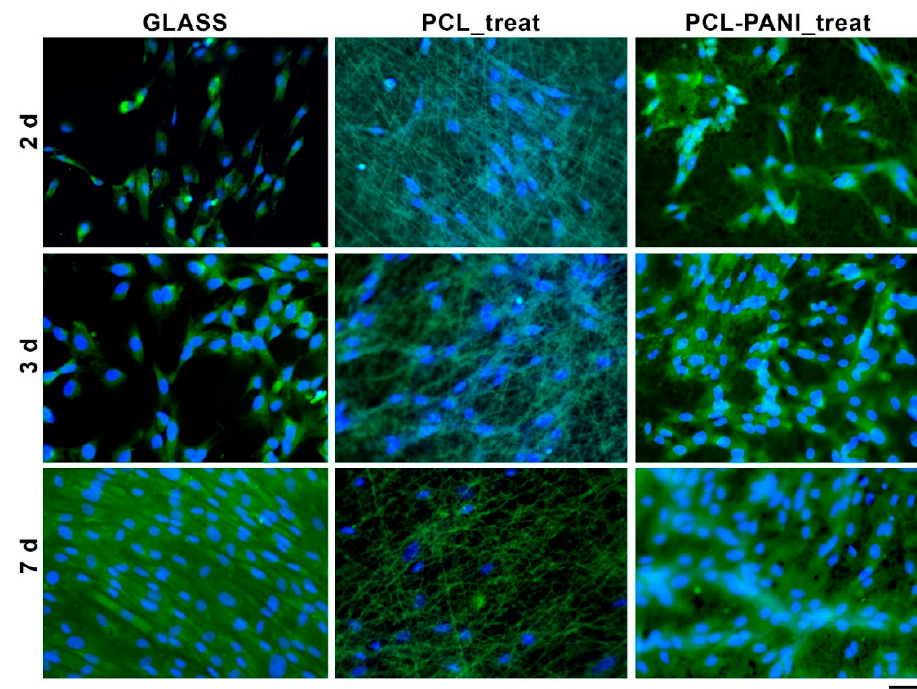
Figure 9. Fluorescent microscopy images of HFF-1 stained with FITC phalloidin (actin filaments) and DAPI (nuclei) after 2, 3 and 7 days of culture (scale bar = 50 µm, magnification = 20×). According to the results obtained from the resazurin assay, the number of cells on the PCL-PANI_treat mats was higher than that on the PCL_treat and GLASS samples at days 2 and 3. Therefore, after 7 days, the cells were uniformly distributed along the direction of the electrospun fibers. The attachment of HFF-1 cells on the electrospun mats was also investigated through FESEM microscopy (Figure 10). The typical spindle-like shape of the fibroblasts was observed for PCL-PANI_treat samples, where the cells appeared healthier and better attached, compared to cells growth on PCL_treat mats.